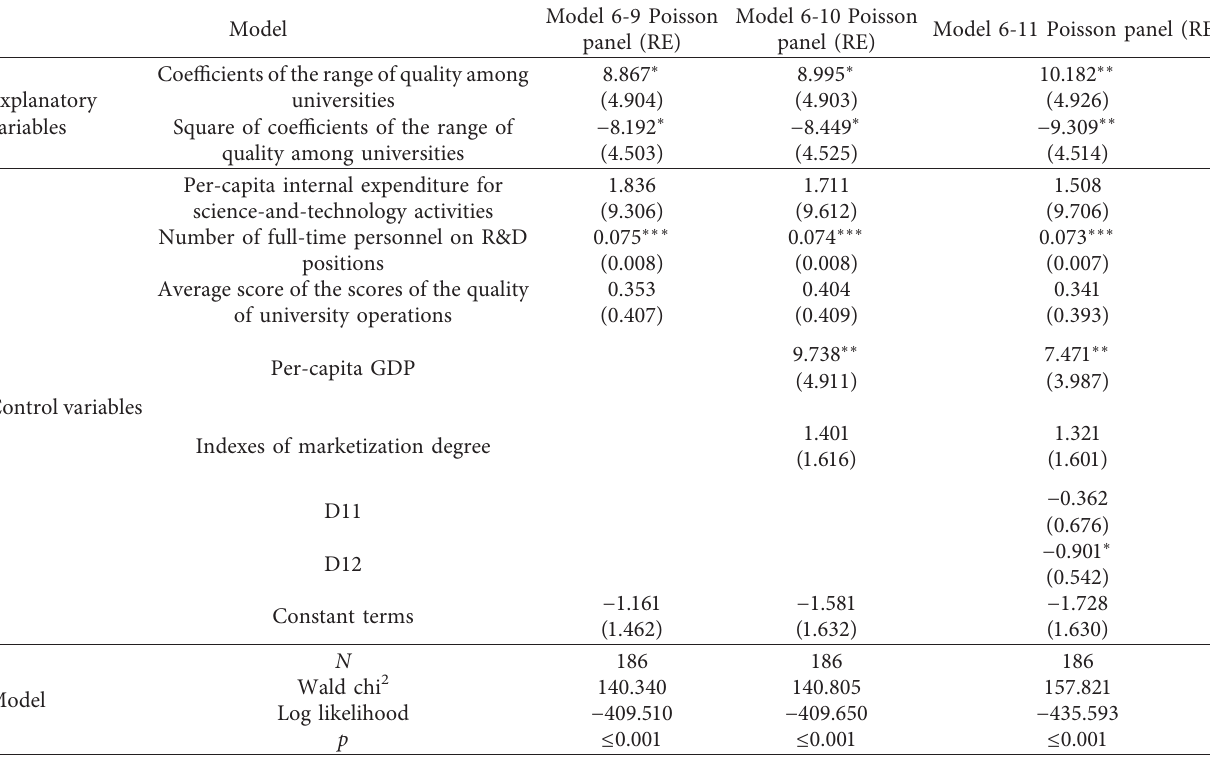
Table 6: Robustness test for the model of regional